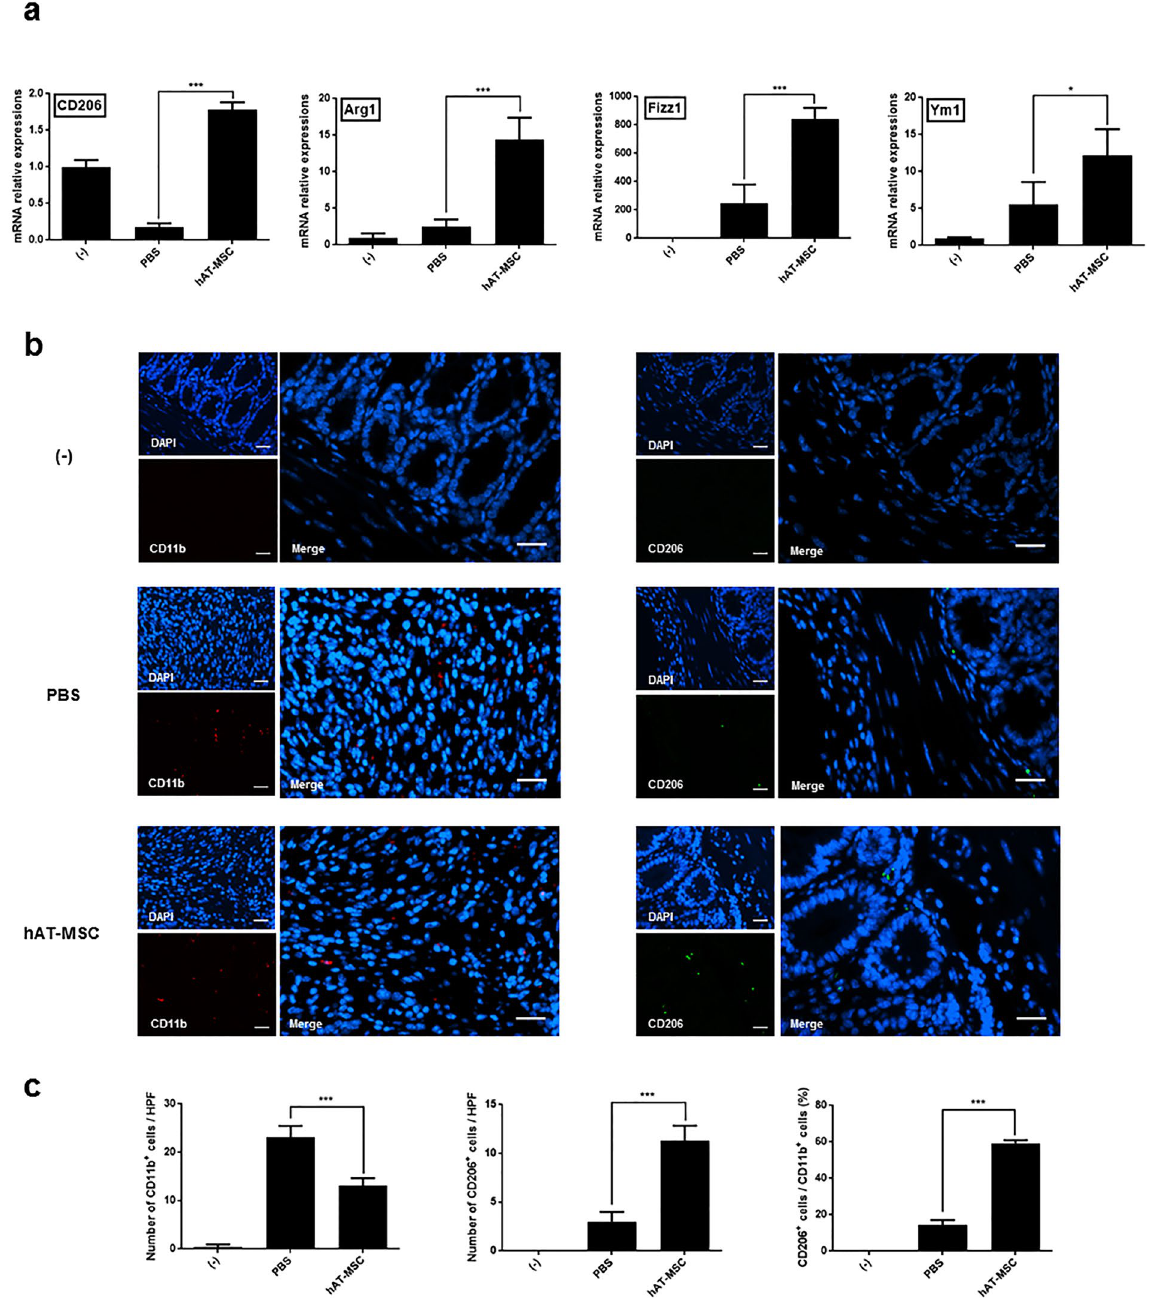
immunofluorescence staining using anti-CD11b or anti-CD206 antibodies. Bars = 30 µ m. ( c ) The number of CD11b- or CD206-positive cells within the inflammatory infiltrates, and the calculated percentage of CD206- positive cells among the CD11b-positive cells. Six to eight mice per group were used. Results are presented as mean ± standard deviation. * P < 0.05, *** P <